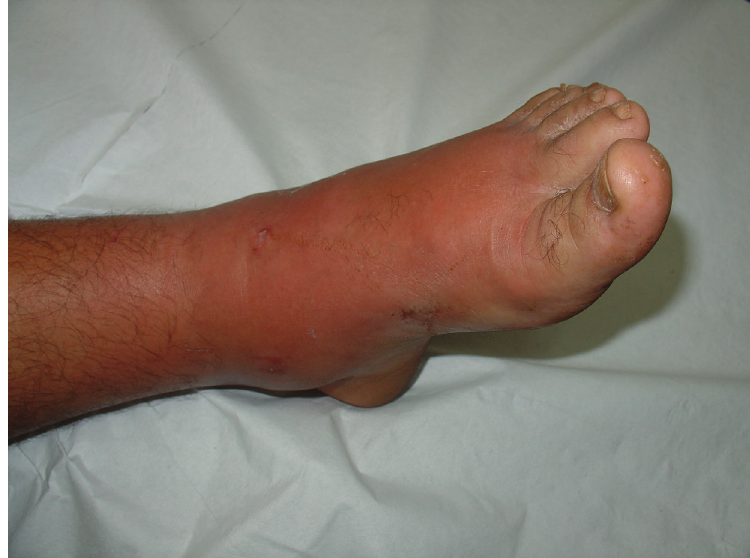
Figure 3 - Wound caused by the Pseudoplatystoma corruscans catfish one day after the sting. The edema and erythema in the foot are associated with the action of the toxins. Photo: Vidal Haddad Junior.